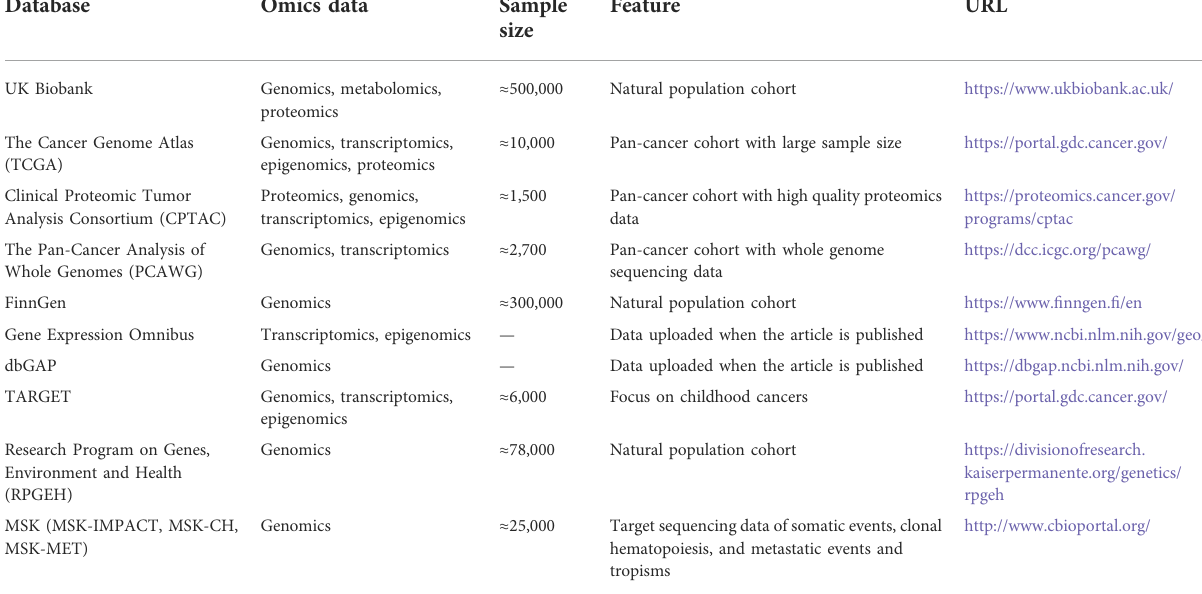
TABLE 1 Introduction of public databases with available pan-cancer omics